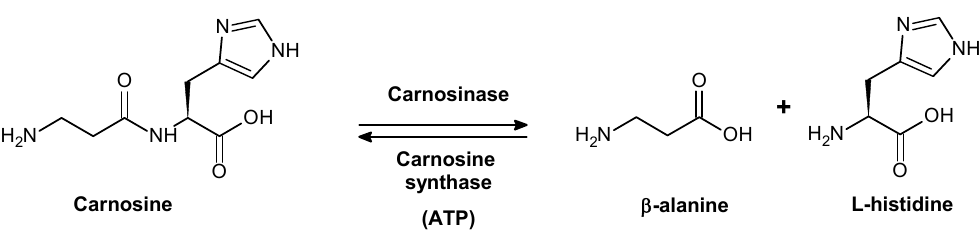
Figure 2. Synthesis and hydrolysis scheme of carnosine under physiological conditions.